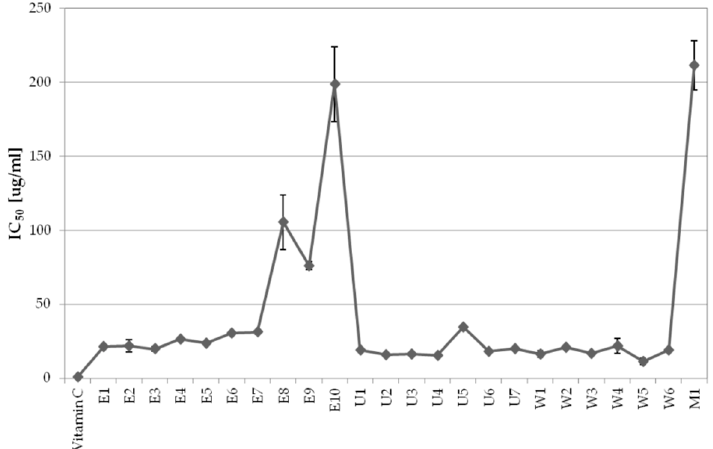
Figure 1. Antioxidant activity of A. biebersteinii extracts prepared using various extraction protocols, displayed as mean IC 50 values ± SD obtained in DPPH scavenging assay; graph shows mean values ± SD, n = 3. E—ASE extracts, U—ultrasounds extracts, W—shaking extracts, M—maceration extract.